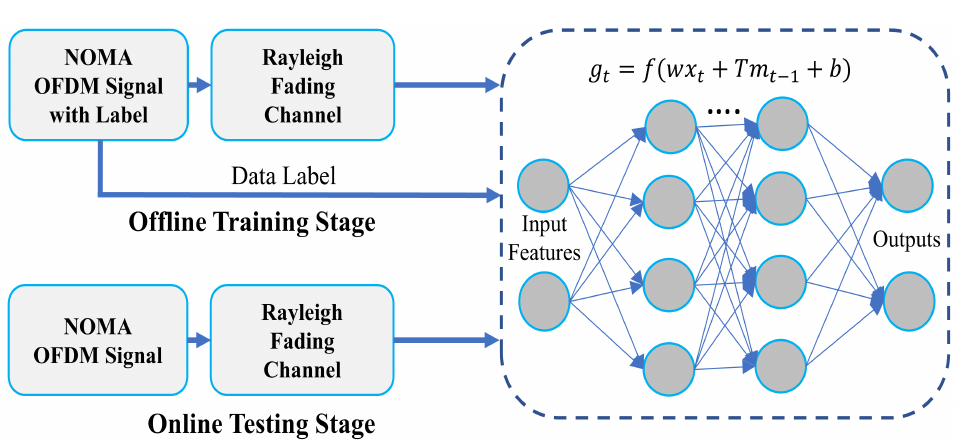
Figure 4. Training and testing process of the proposed model.